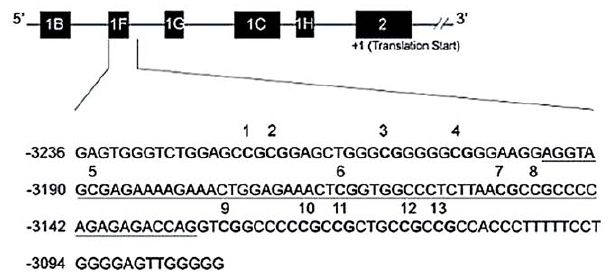
Figure 1. Schematic representation of human NR3C1 5 9 regulatory region, and the specific region analyzed by bisulfite pyrosequencing. The upper diagram represents the multiple first exons, and the second exon (2) which represents the translational start. All numbering is based on the translational start site ( + 1), which is located 13 nucleotides within the start of exon 2. The lower region is the region analyzed by pyrosequencing, with the 13 CpG sites in bold and numbered above the sequence, and the full exon 1F region underlined.